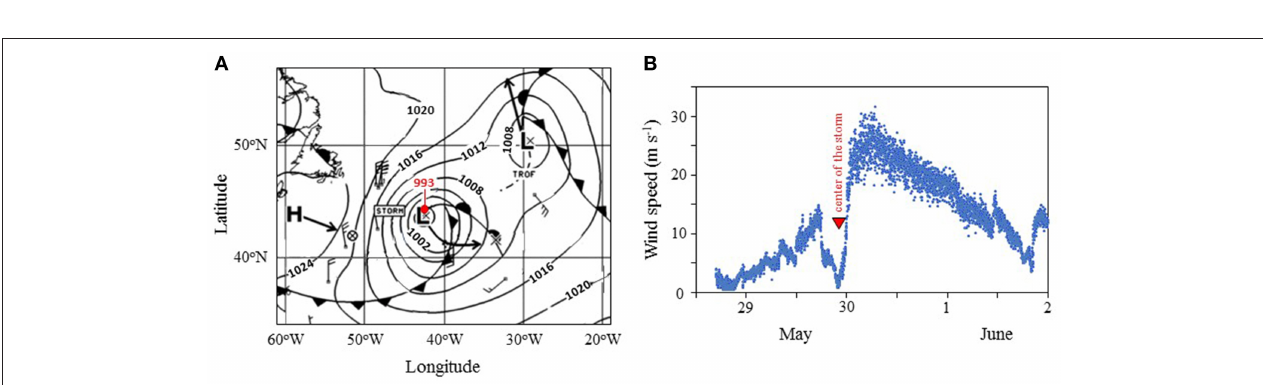
FIGURE 10 | Meteorological conditions during occupation of Station S5 of NAAMES 2. (A) Atlantic Surface Analysis Map from 5/30/2016 at 00 UTC. Contours show surface pressure (mb). Red dot indicates location of R/V Atlantis (surface pressure = 993mb). L = low pressure system, with arrow showing forecasted trajectory. H = high pressure system, with arrow showing forecasted trajectory. Lines with solid triangles = cold front. Lines with solid semicircles = warm front. Data from the National Oceanographic and Atmospheric Administration (NOAA). (B) Wind speed temporal record measured on the ship during occupation of Station S5 of NAAMES 2.